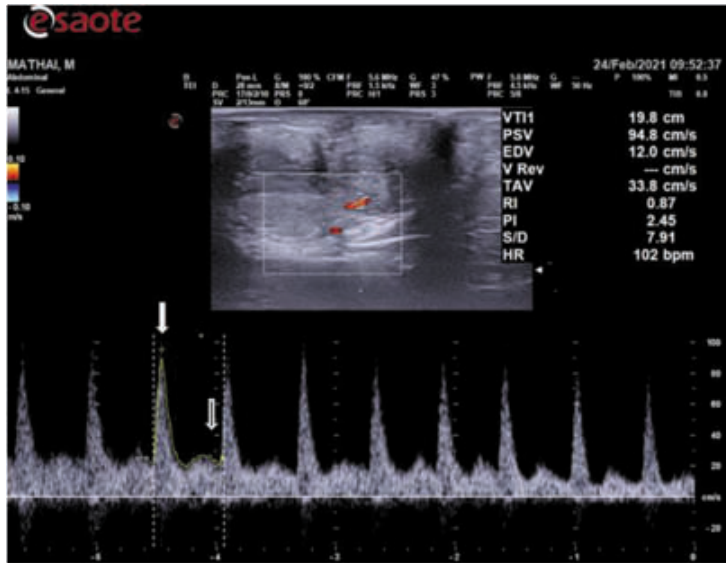
Fig. 2 Triplex Doppler of ventral perineal artery in female dog. A small volume sample is placed on the coloured ventral perineal artery, obtaining the spectral tracing of the vellel. Observe the waveform, characterized by a systolic peak (white arrow) end diastolic velocity (hollow arrow) that trans-perineal approach to evaluate ventral Ultrasonographic characterisation of perineal artery makes the examination more uterine artery in bitches during different stages feasible for the operator and comfortable for the bitch. However, there are no data available in the literature concerning the ultrasonographic characterisation of the ventral perineal artery in the hinder the uterine artery evaluation. We feel